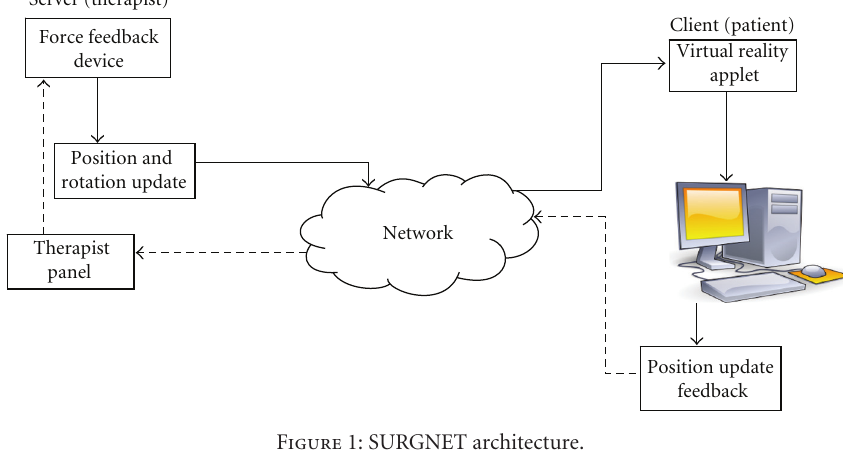
Figure 1: SURGNET architecture.